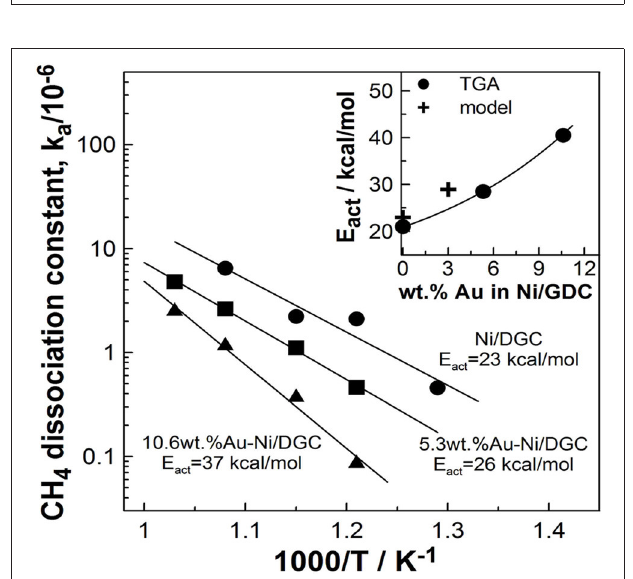
FIGURE 8 | Arrhenius plots of the CH 4 dissociation reaction as calculated by TGA analysis using 0, 5.3, and 10.6 wt.% Au-Ni/GDC anodes. Inset: Effect of Au content on the activation energy of CH 4 dissociation. Comparison between TGA analysis results with model predicted values. Reprinted with permission from Souentie et al. (2013).